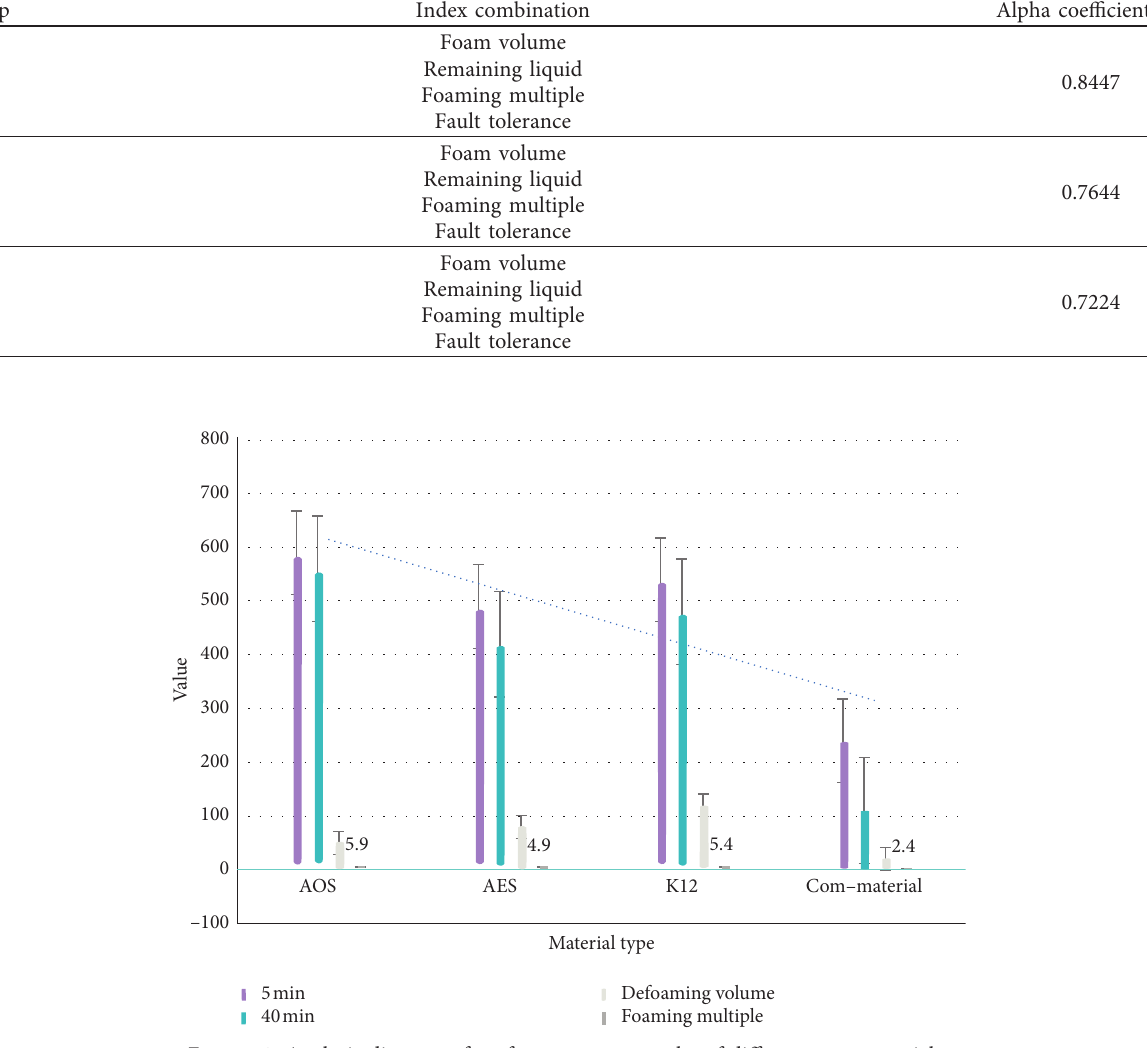
Figure 1: Analysis diagram of performance test results of different